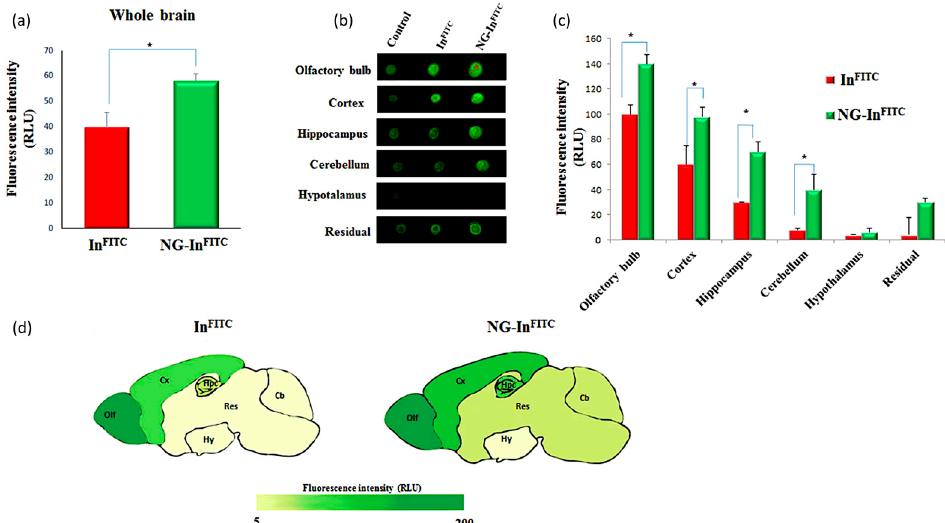
Figure 7. Brain biodistribution of FITC-labelled PVP-g-AA and insulin-conjugated nanogels (NG-In) after 30 min from intranasal (i.n.) administration. ( a ) FITC fluorescence intensity of free insulin (InFITC) (red) and NG-InFITC (green) in the whole brain after the i.n. inoculation of 10 μ L per nostril of the two formulations. ( b ) Fluorescence dot spot analysis of different brain areas. ( c ) Distribution of FITC fluorescence signaling levels in the different brain areas of free insulin (red) and NG-In (green). ( d ) Map brain indicating the levels of free insulin (left) and NG-In (right) in the olfactory bulb (Olf), cortex (Cx), hyppocampus (Hpc), hypotalamyus (Hy), cerebellum (Cb) and residual areas (Res). Each data point represents the mean ± SD of n = 5. * p < 0.05 vs. indicated groups. From [81].